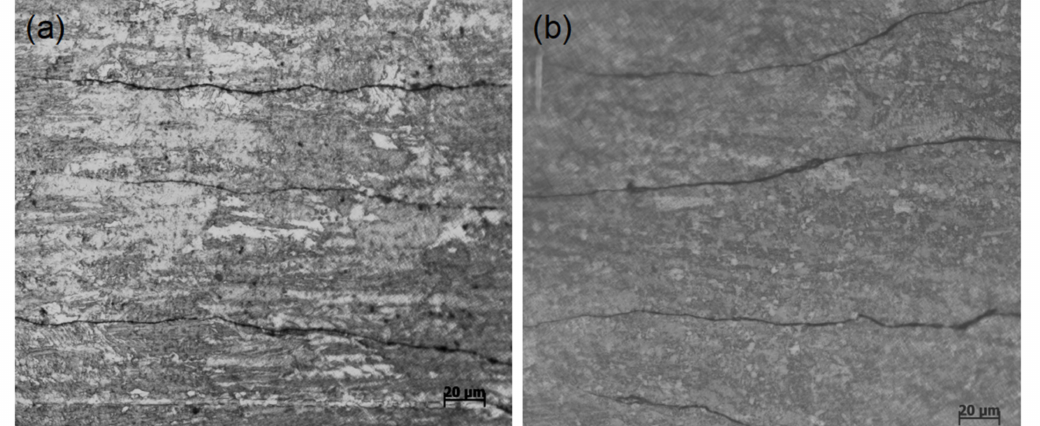
Figure 5. OM micrographs of the ARB process composites microstructures. ( a ) The EPD 4 min and ( b ) the EPD 8 min.